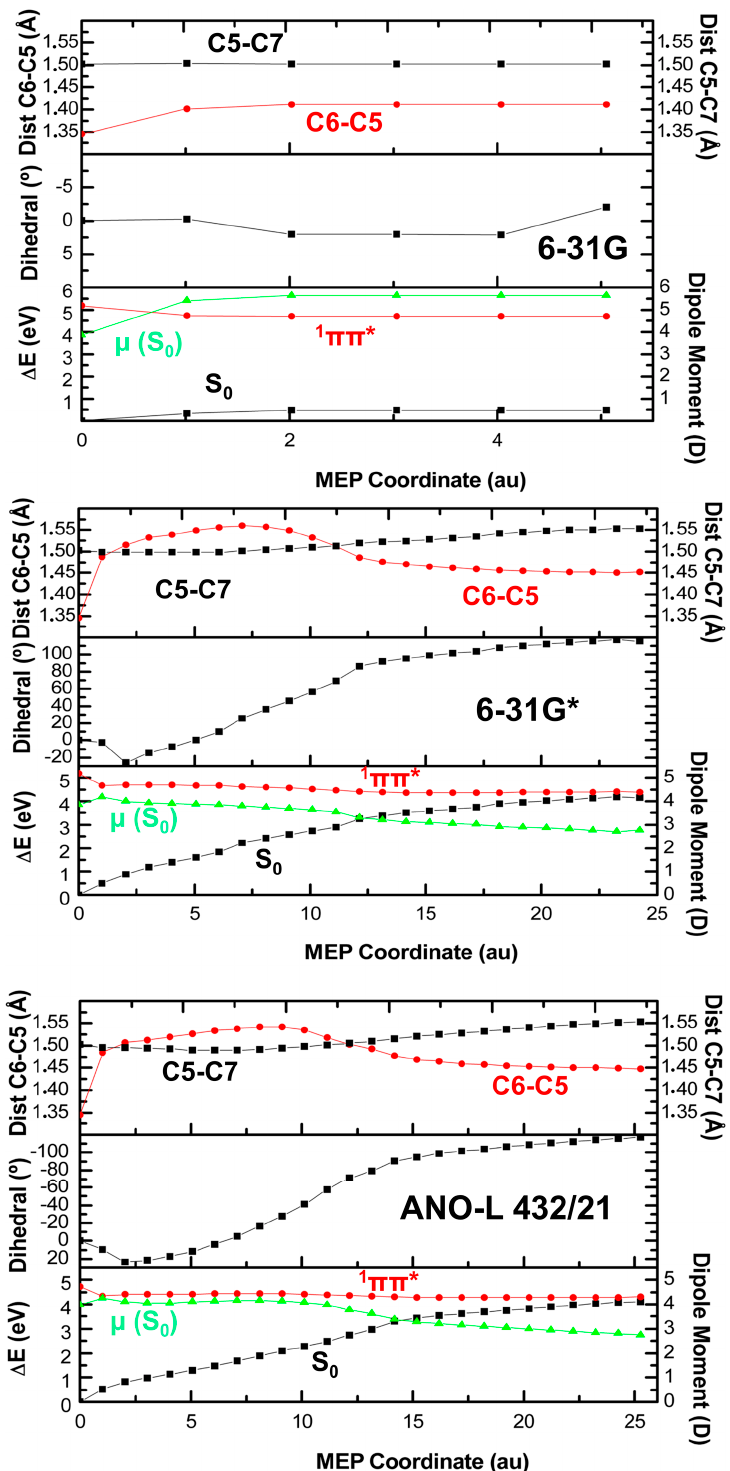
Figure 2. Complete active space second-order perturbation theory (CASPT2) energies and CASSCF dipole moments ( µ ) of the ground and lowest-lying 1 ( ππ *) excited state plus main geometrical distortions along the MEPs of the 1 ( ππ *) from the Franck-Condon region computed with the CASPT2//CASSCF(10,8) protocol and the 6-31G, 6-31G*, and atomic natural orbital (ANO)-L 432/21 basis sets. Results corresponding to the CASPT2//CASSCF(10,11)/6-31G*, CASPT2//CASSCF(10,8)/ANO-S 321/21, and CASPT2//CASSCF(10,8)/ANO-L 321/21 levels of theory can be found in Figure